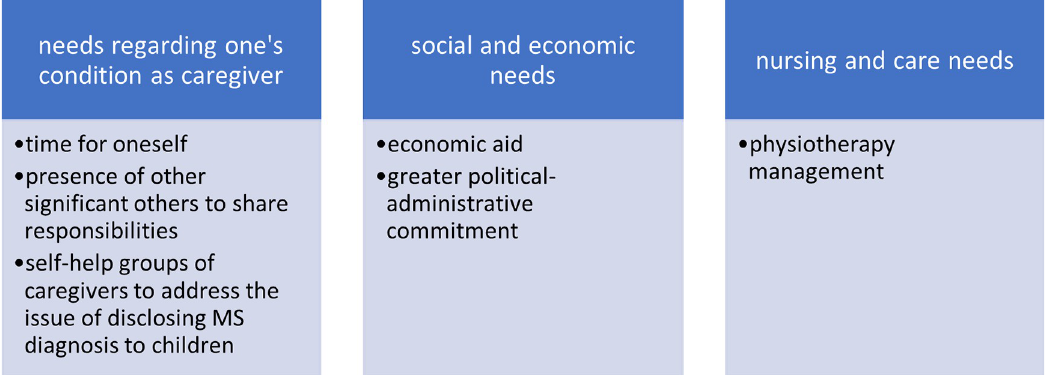
Fig 4. Needs expressed, grouped by type of